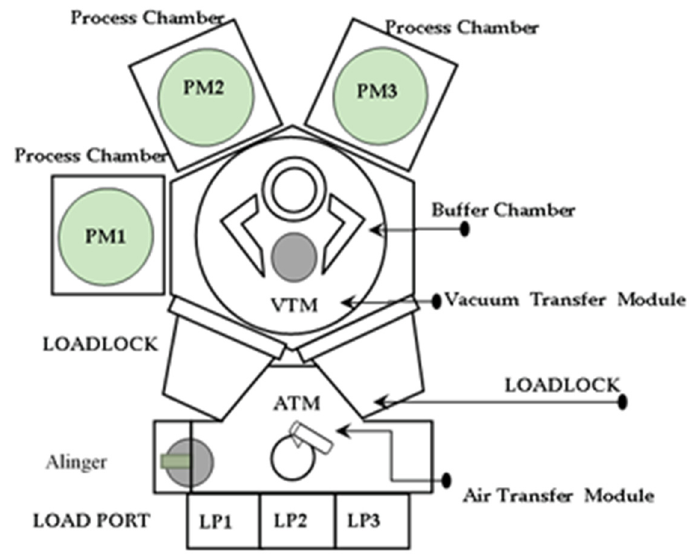
Figure 1. Cluster